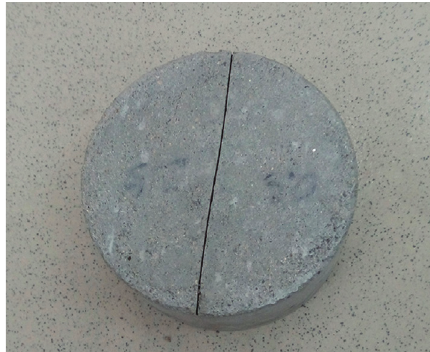
Figure 5: Specimen of NEL test.